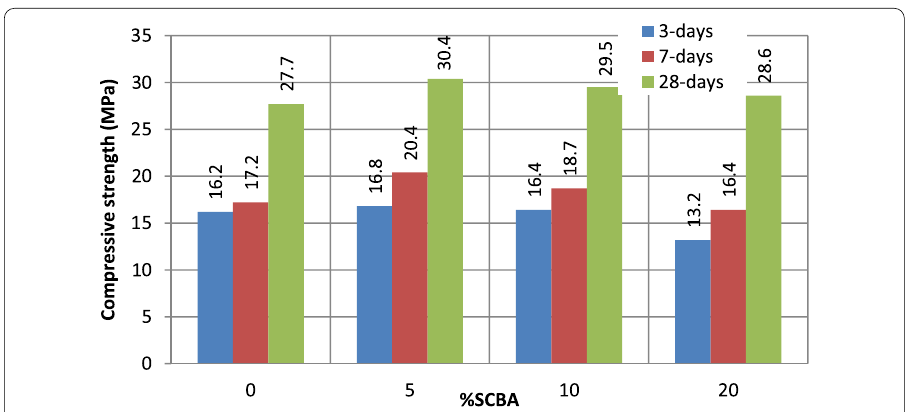
Fig. 2 Compressive strength of cement mortar at ages 3, 7, and 28